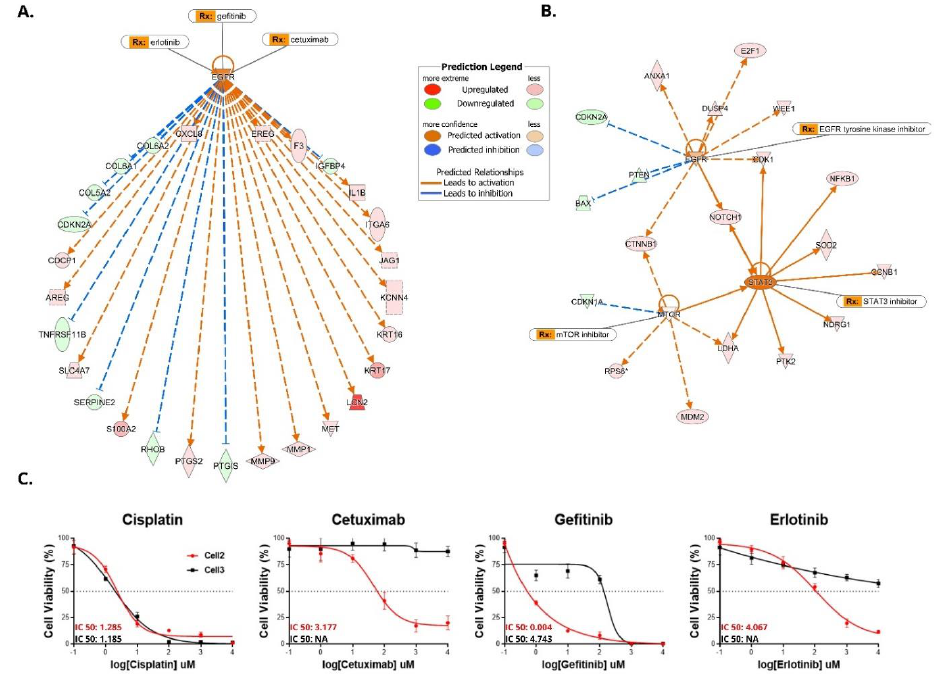
Figure 4. Enrichment analysis of direct and indirect mRNA interactions and proteins dysregulated in penile cancer (PeCa) cells show EGFR as a core molecule. Sensitivity assays to EGFR inhibitors are depicted for cells 2 and 3. Upstream regulator analysis (IPA, Ingenuity Pathway Analysis) indicates direct (solid lines) and indirect (dashed lines) interaction of mRNA ( A ) and proteins, which is exemplified in PeCa-derived cell 2. ( B ) EGFR is a core molecule in both mRNA and protein analyses. ( C ) Chemosensitivity assays were performed in cell 2 and cell 3 for the identification of IC50 and dose-response curves. Cells were treated with cisplatin and EGFR inhibitors (cetuximab, gefitinib, and erlotinib). Cell 2 and cell 3 were sensitive to cisplatin. Only cell 2 (EGFR overexpression) was sensitive to EGFR inhibitors.